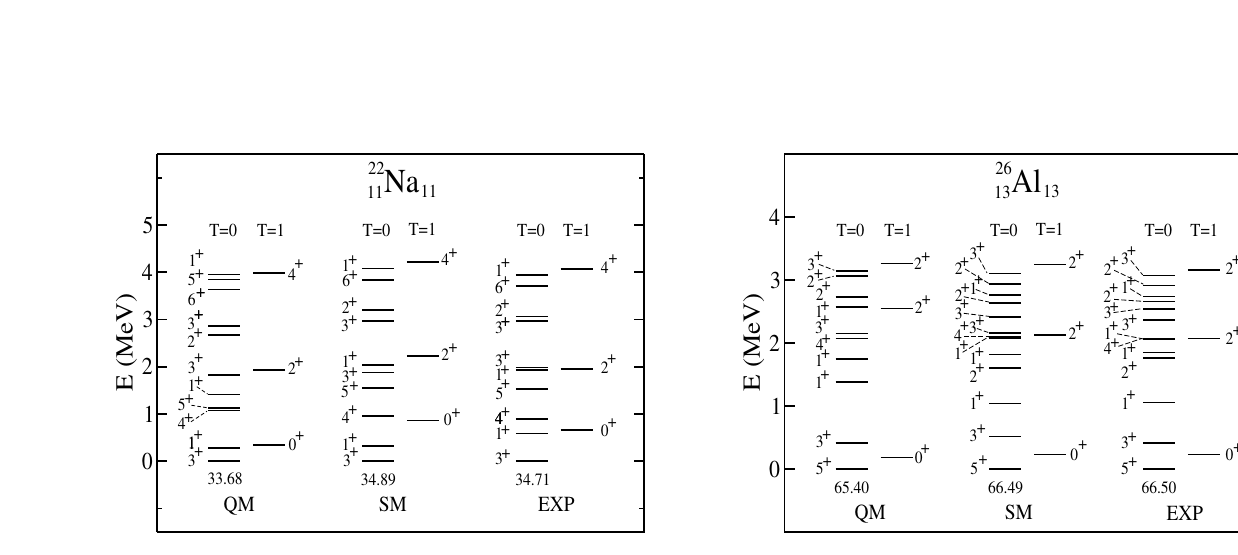
Figure 4. The same as in Fig. 3 for 26